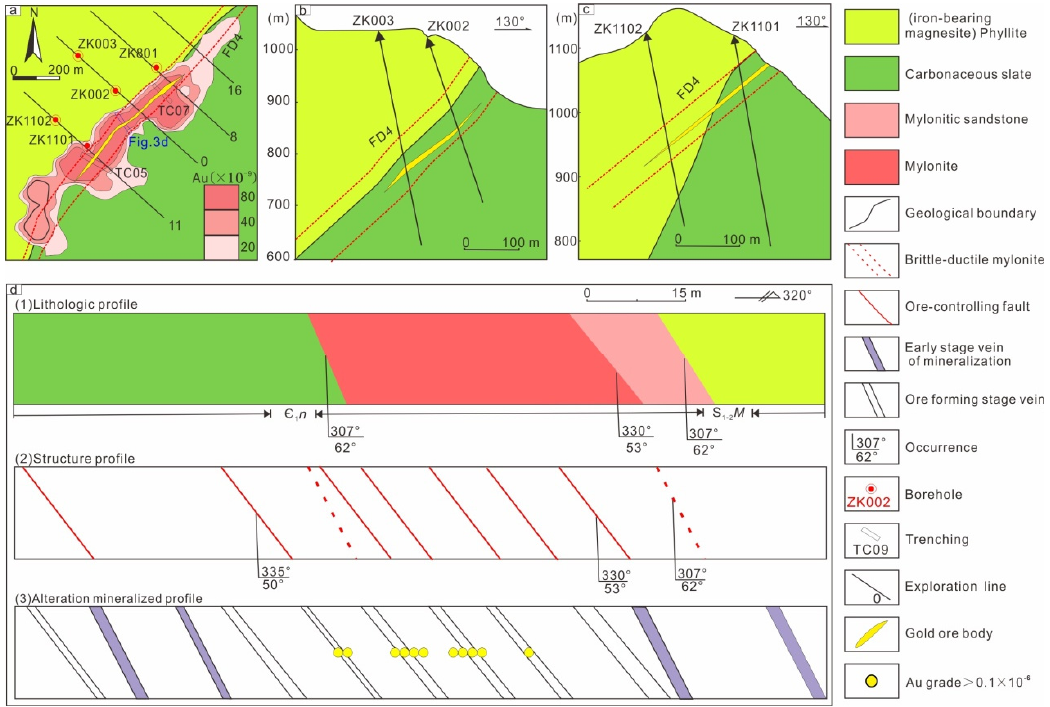
Figure 3. Deposit geology and soil geochemistry ( a ), exploration line section ( b , c ), and cross–section of the exploratory trench TC09 ( d ) in the Xinjiazui gold deposit (Liu et al., 2022